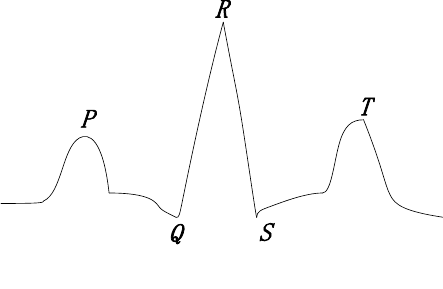
Figure 5. Illustration of standard ECG